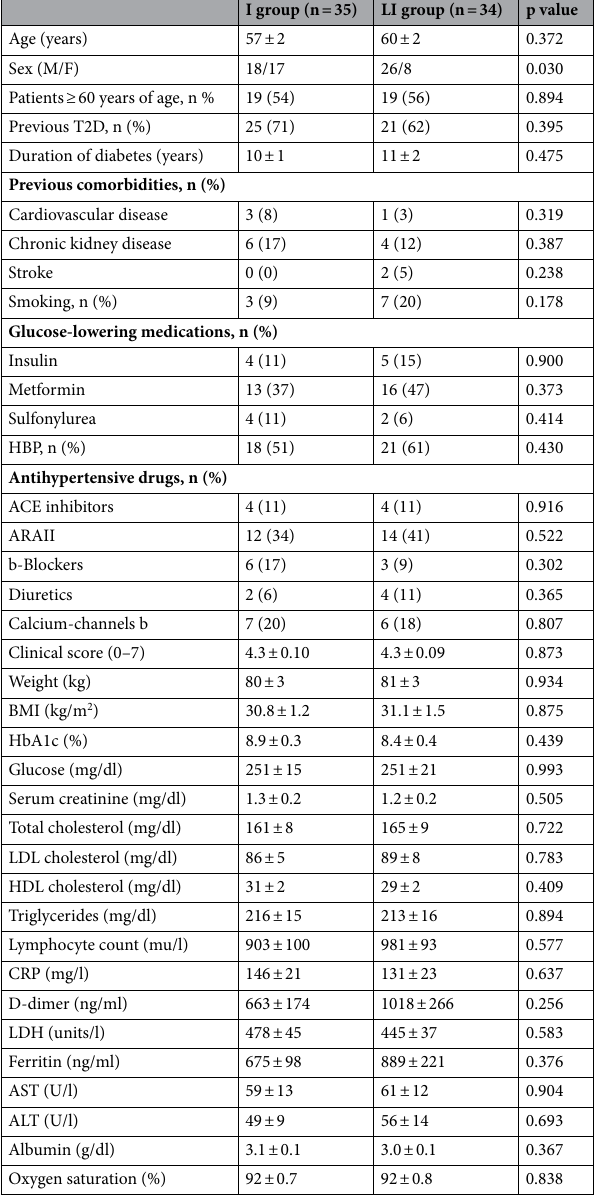
Table 1. Baseline and clinical characteristics between the study groups. Data are mean ± SEM. CRP C reactive protein, LDH lactate dehydrogenase, AST aspartate aminotransferase, ALT alanine